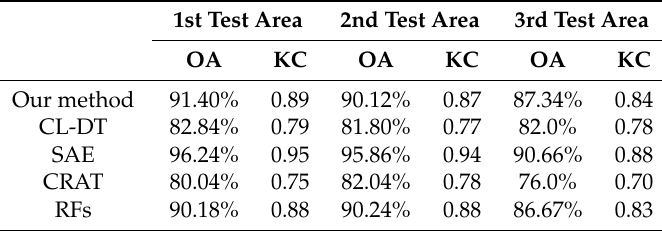
Table 22. Comparison of over accuracy (OA) and Kappa coefficient (KC) in the three test